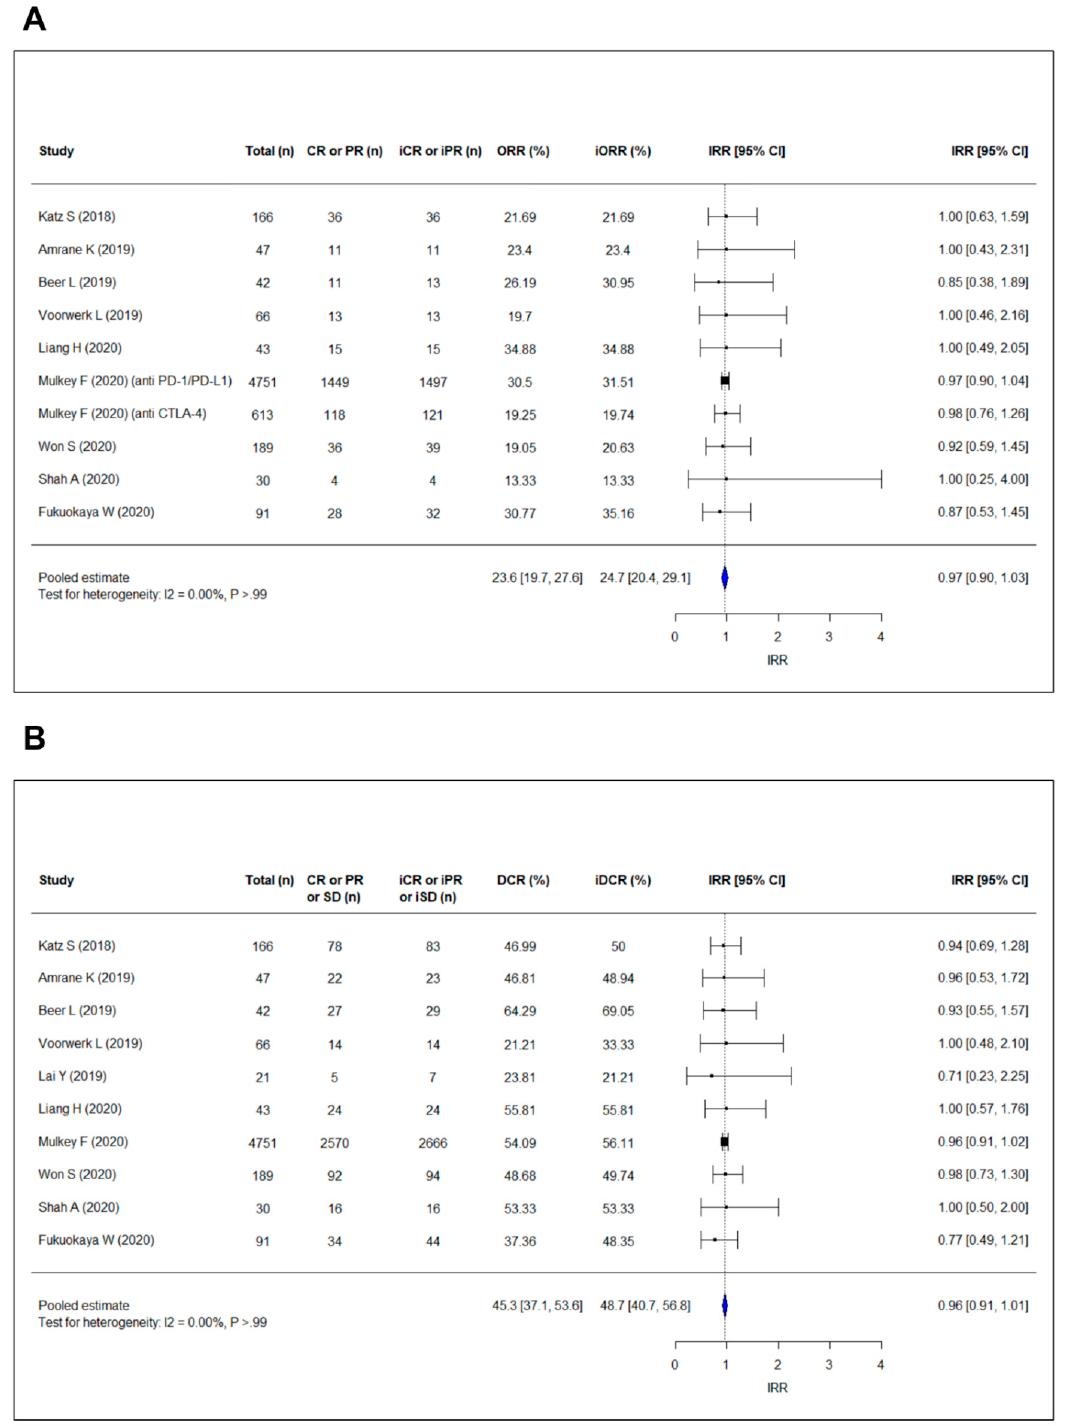
Figure 2. Forest plots showing the pooled estimate of ( A ) incidence rate ratio of ORR and ( B ) incidence rate ratio of DCR according to RECIST 1.1 and iRECIST. The pooled incidence rate ratio of ORR per RECIST 1.1 and iORR per iRECIST is 0.97 (95% CI, 0.90–1.03), and the pooled incidence rate ratio of DCR per RECIST 1.1 and iDCR per iRECIST is 0.96 (95% CI, 0.91–1.01), indicating no significant increase in both ORR and DCR using iRECIST compared with RECIST 1.1. “i” indicates immune responses assigned using iRECIST. Abbreviations: CI, confidence interval; CR, complete response; DCR, discase control rate; IRR, incidence rate ratio; ORR, overall response rate; PR, partial response; SD, stable